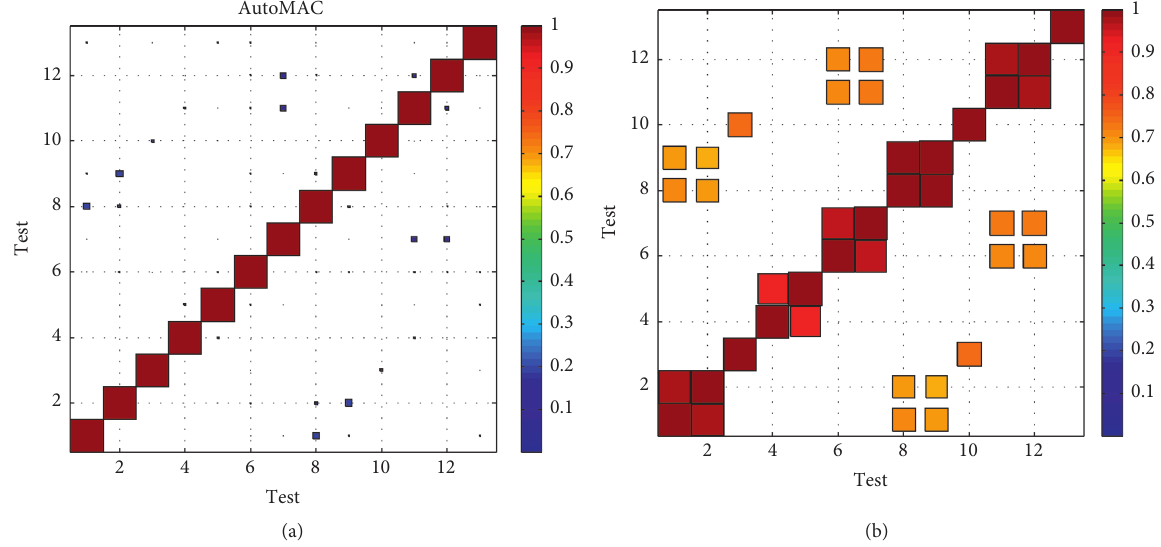
Figure 20: Autocorrelation based on the test data. (a) AutoMAC of the test. (b) Autocorrelation analysis by RTMs of the test.